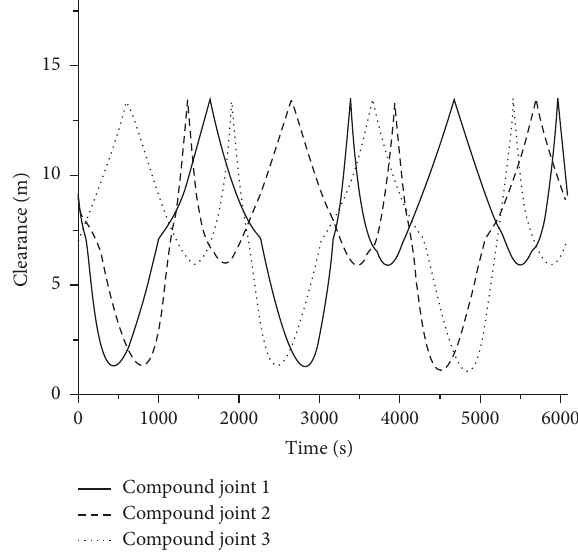
Figure 29: Distance between upper and lower U plate of each compound joint with time.